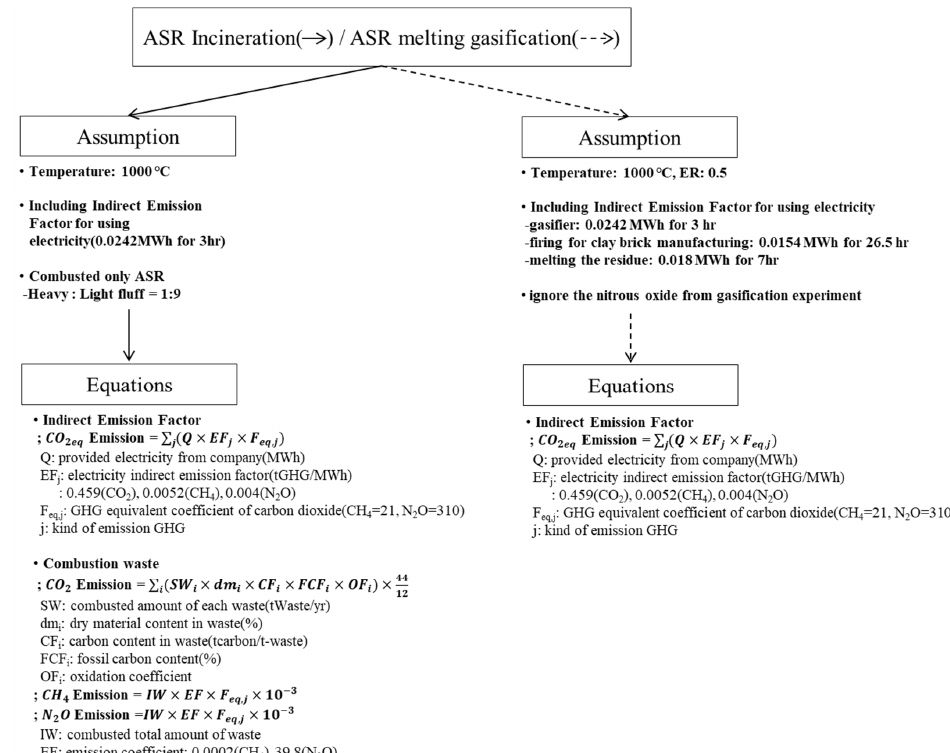
Figure 2. Process of Present Study for Efficient ASR Disposal.